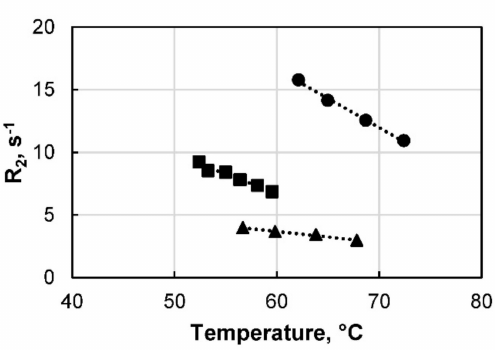
Figure 2. R 2 measured for the weak (triangles), intermediate (squares), and half-strong (circles) black liquor samples at di ff erent